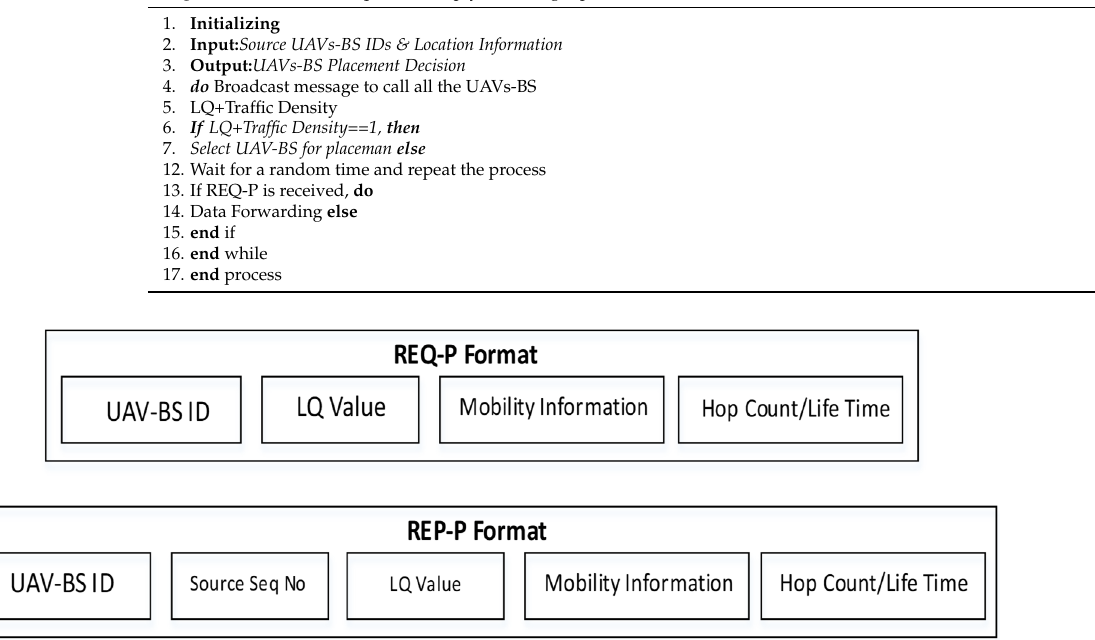
Figure 3. Request and reply packets format.